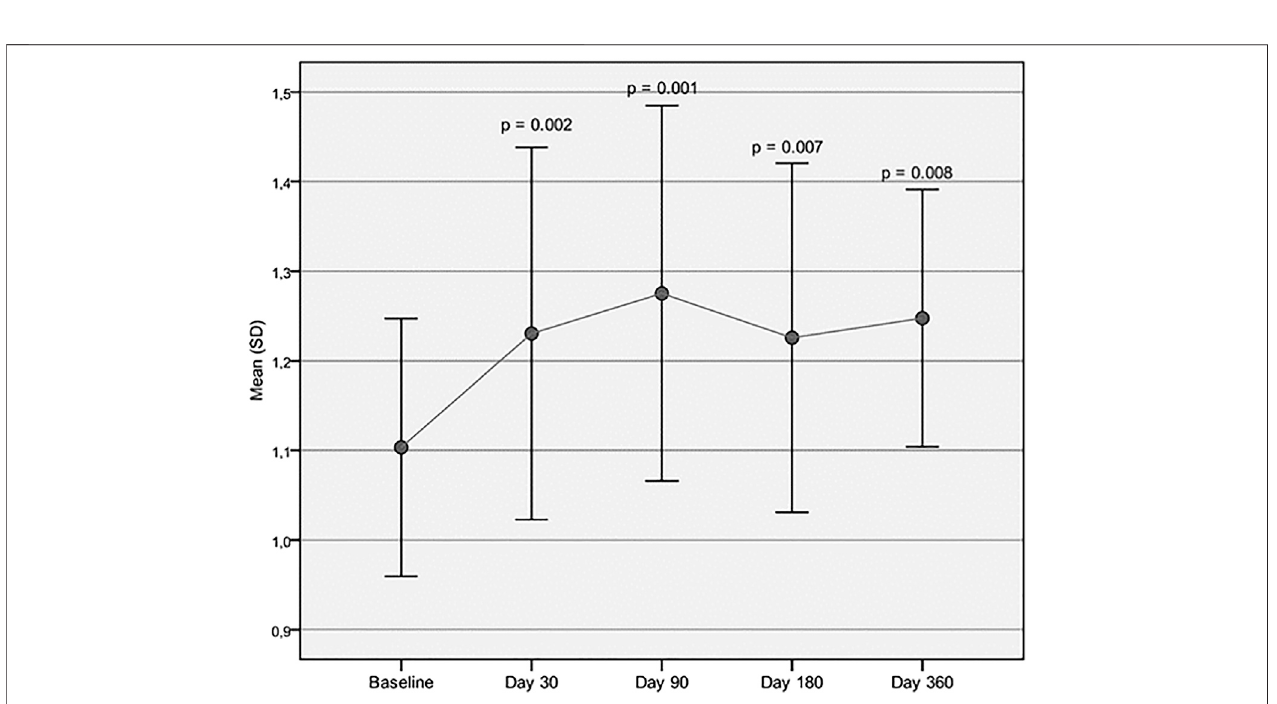
FIGURE 2 | Velocity assessed through GAIT analysis. Mean velocity (m/s) at baseline is compared to mean velocity recorded at each follow-up visit.